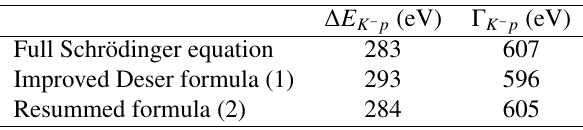
Table 1. Level shift and width of kaonic hydrogen obtained by solving the Schrödinger equation with the Kyoto ¯ KN potential, and by using the improved Deser formula (1) and its resummed version (2). The numerical data are taken from Ref.